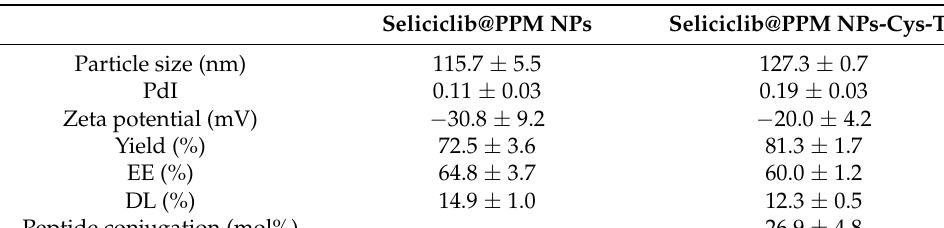
Table 1. The characteristics of seliciclib@PLGA-PEG-maleimide nanoparticles (seliciclib@PPM NPs) and seliciclib@PPM NPs-Cys-T7.